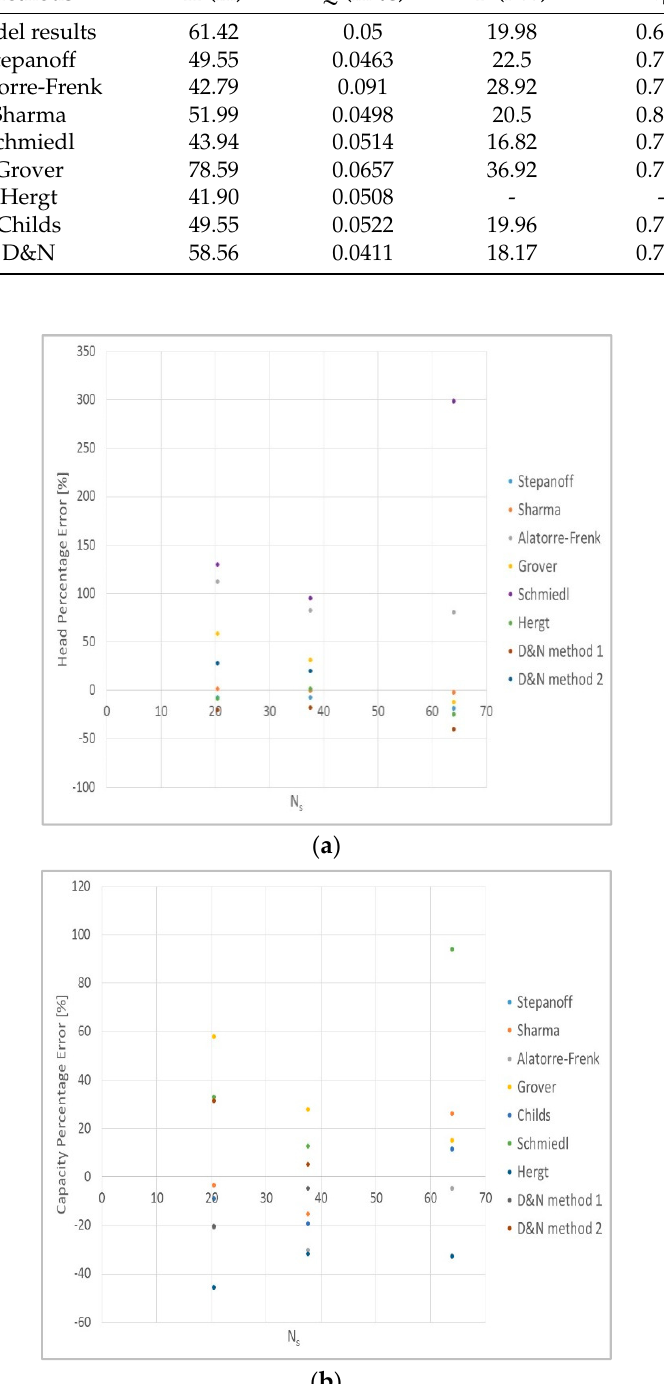
Figure 10. Prediction methods comparison. ( a ) Head Percentage Error; ( b ) Capacity Percentage Error.